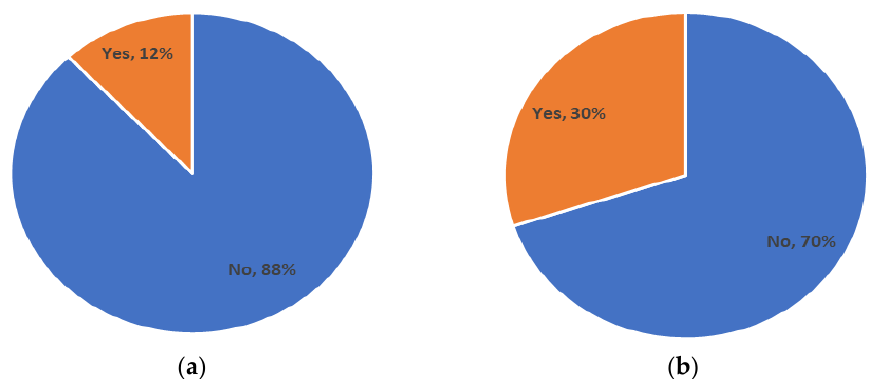
Figure 5. Questions around awareness of AHR legislation. ( a ) Awareness that Ireland has draft legislation to regulate AHR clinics. ( b ) Awareness that Ireland is one of the only European countries without regulated AHR clinics .